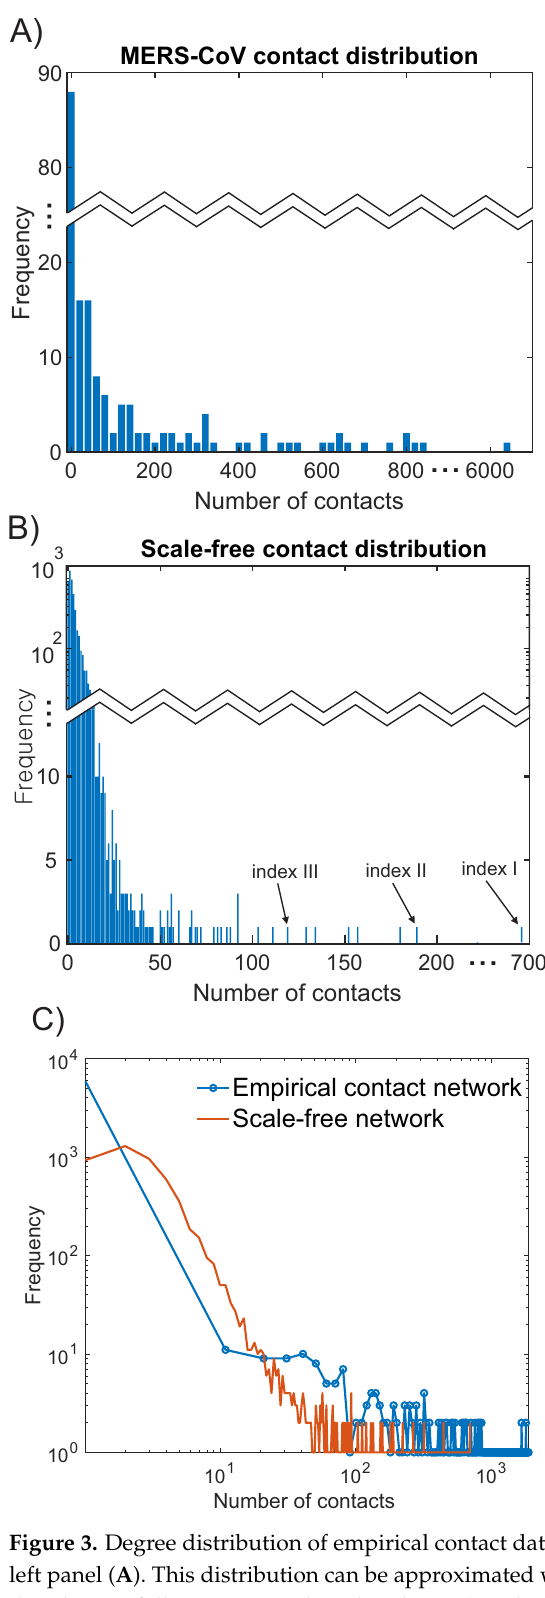
Figure 3. Degree distribution of empirical contact data for 186 confirmed cases is presented in the left panel ( A ). This distribution can be approximated with a scale-free network framework (degree distribution follows a power law distribution) in the right panel ( B ). The right panel shows three distinct index cases with different numbers of contacts. The bottom panel ( C ) compares the two contact distributions fitted to the power law distribution x − γ